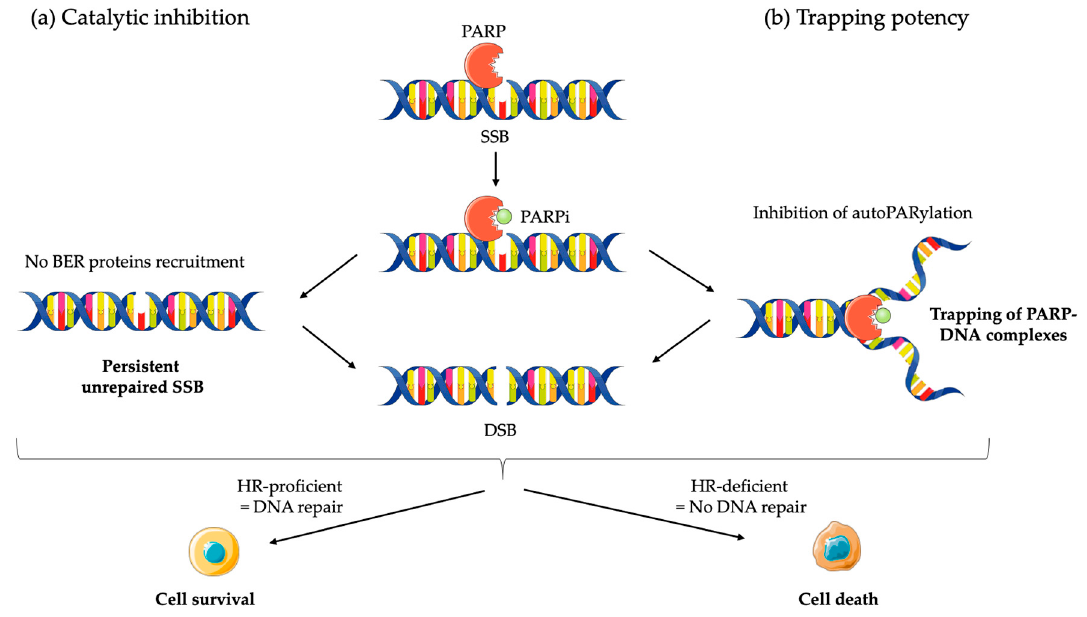
Figure 1. Mechanisms of action of PARP inhibitors (PARPi): ( a ) PARPi impedes PARP enzyme activity (or catalytic inhibition) and interferes with repair of single strand breaks (SSB) by disrupting the base excision repair (BER) pathway; ( b ) PARPi also causes trapping of PARP proteins on DNA by inhibiting autoPARylation. In homologous recombination (HR) proficient normal cells, DNA is repair and cell survive. The result in unresolved DNA double strand breaks (DSB) in HR deficient cells leads to cell death.